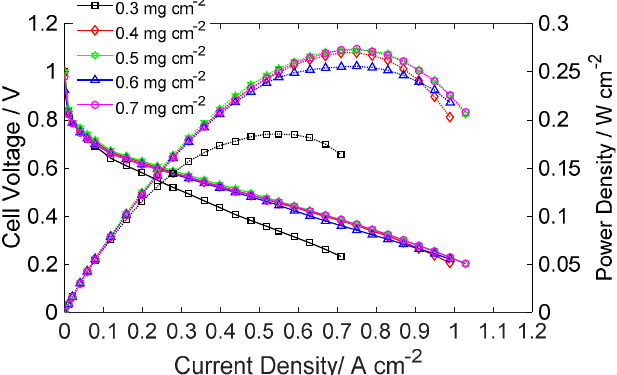
Figure 2. Polarization curves of a single cell with various Pt loadings.